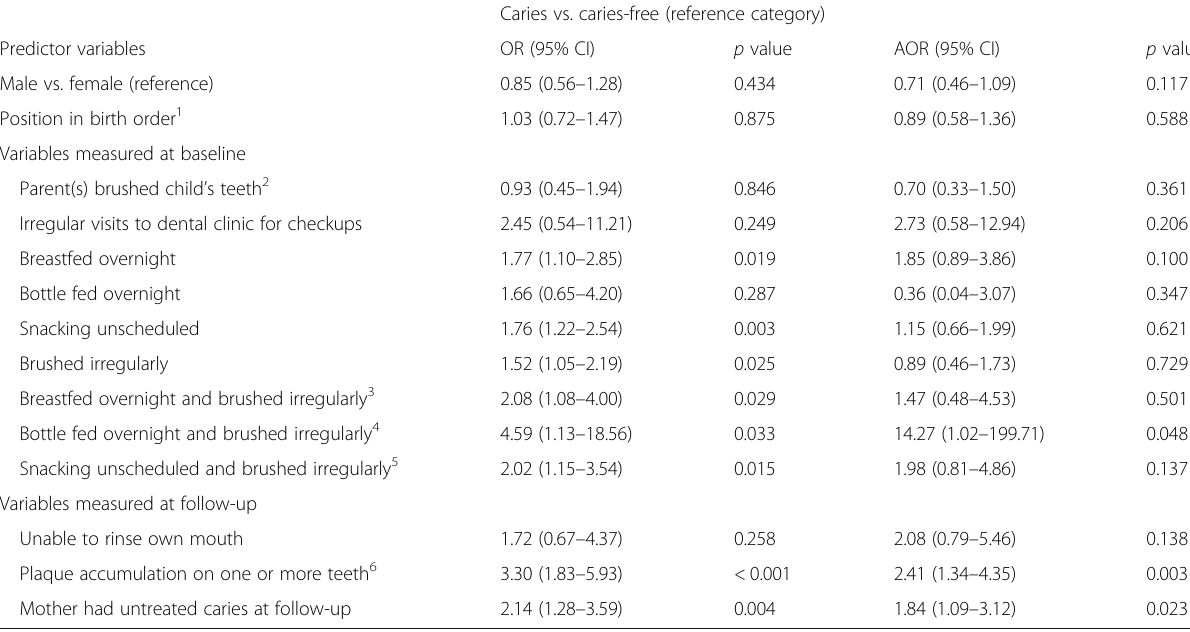
Table 5 Logistic regression identifying predictors of having caries at follow-up ( n = 463) Caries vs. caries-free (reference